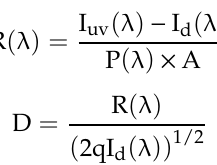
Figure 10. ( a ) Spectral responsivity of the ZnO@A-SWNT UV PD, photoresponses of the ( b ) ZnO NPs and ( c ) ZnO@A-SWNT PDs under UV irradiation (365 nm, 0.47 mW/cm 2 ) at a voltage bias of 2V. The insets in ( b ) and ( c ) show the recovery times of ZnO NPs and ZnO@A-SWNT PDs, respectively. On/off switching properties with time-dependent measurements for ( d ) ZnO NPs and ( e ) ZnO@A-SWNT PDs.